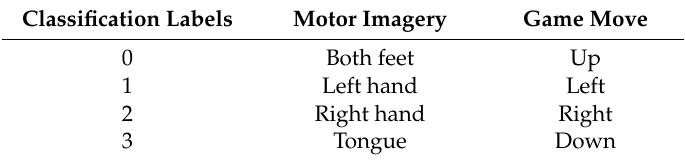
Figure 5. The graphic user interface of the maze game ( a ) The ball moved 1 step from the initial position; ( b ) The ball moved 4 steps from the initial position. Table 1. The mapping relationship between the motor imagery tasks and movement